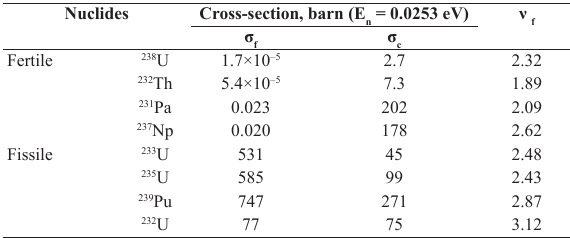
Table 2. Neutron fission/capture cross-sections at a heat spot and the number of neutrons per fission event (Babichev et al. 1991; Maslov et al. 2004; Shibata et al. 2011; Soppera et al. 2014). Nuclides Cross-section, barn (E = 0.0253 eV) n